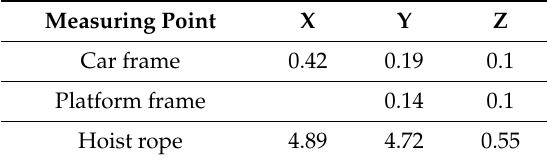
Table 4. Peak acceleration of each component in constant speed period (m/s 2 ).